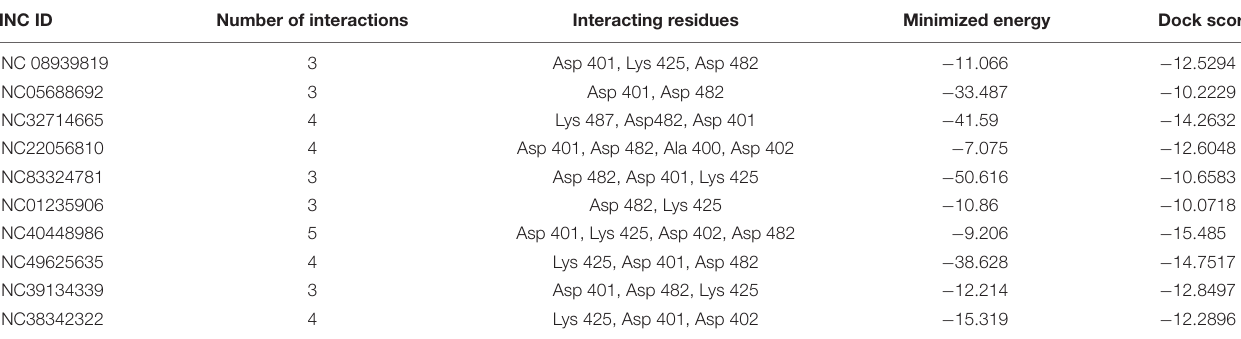
FIGURE 11 | Interaction of 50S ribosomal protein L28 with ZINC03872713 (colored in red). The interacting residues (green) are shown bonding (dotted lines) with the ligand. TABLE 14 | 2-Isopropylmalate synthase and its interaction profile with docked compounds their ZINC ID, minimized energy, number of interactions, dock score, and interactive